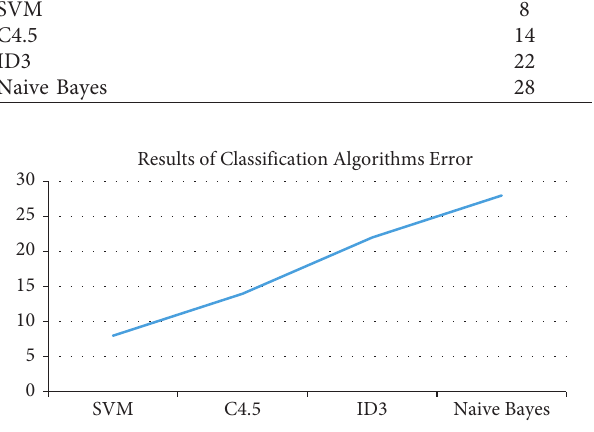
Figure 4: Error rate results of classification algorithms.